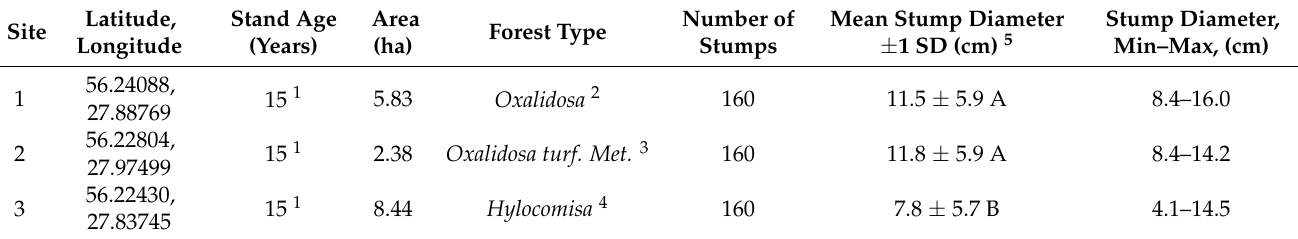
Table 1. Description of experimental sites and stump